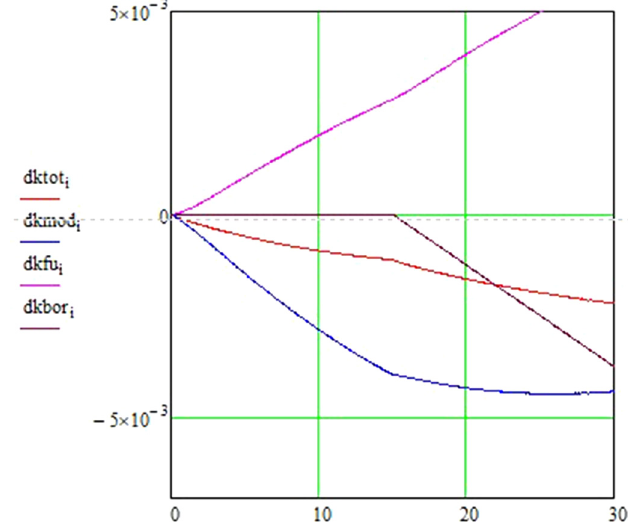
Fig. B3. Reactivity contributions from moderator density, dkmod, fuel, dkfu, and boration, dkbor, together with total reactivity